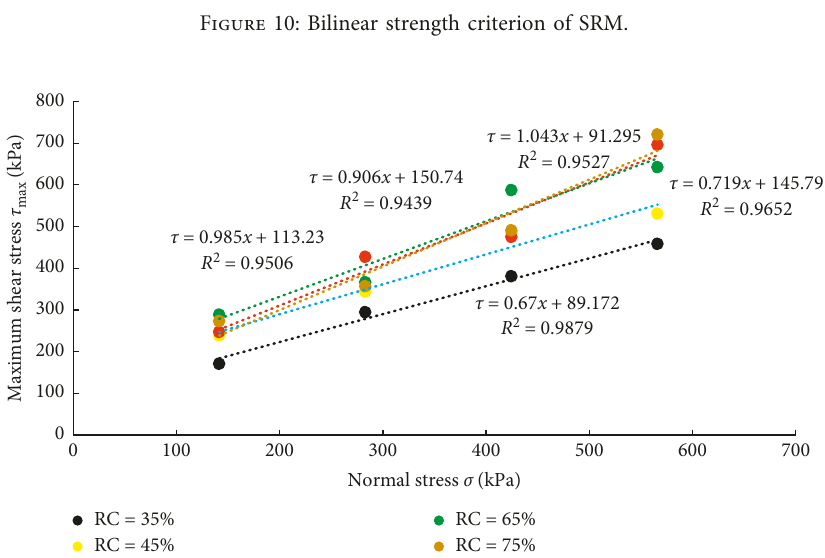
Figure 11: Linear regression curves of shear strength of different rock particle contents.